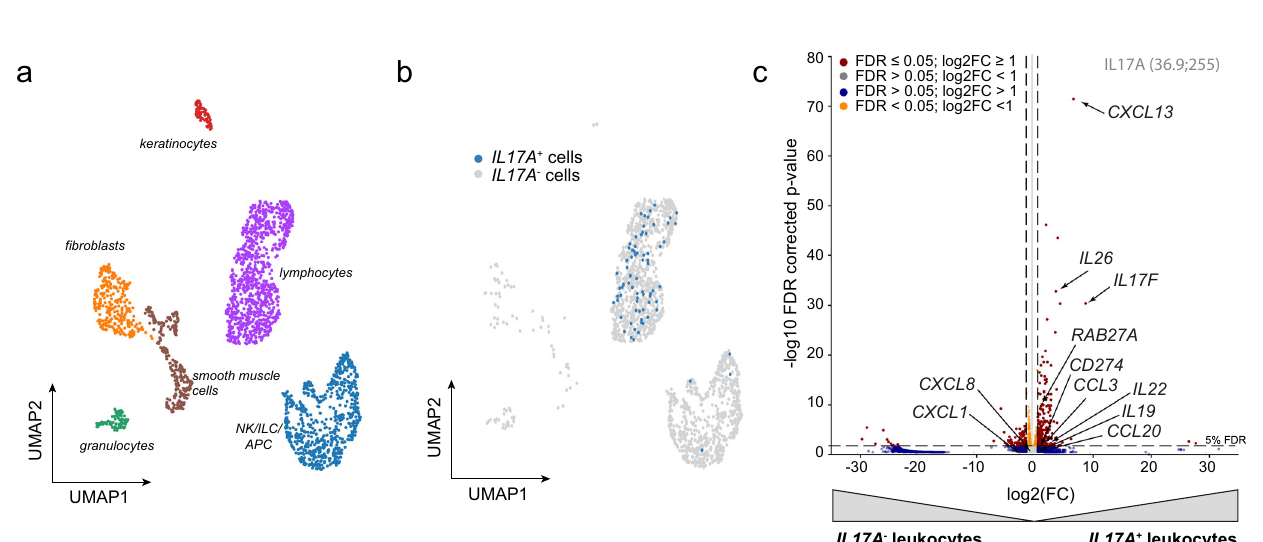
Fig. 3 | IL17A transcript-positive leukocyte spots are characterized by Th17 markers and IL17A tissue response genes. a UMAP (Uniform Manifold Approx- imation and Projection) plot showing the distribution of spots within the analyzed diseases AD, LP and Pso and non-lesional (NL) skin. b ST spots expressing IL17A transcripts and leukocyte marker genes and their location in epidermis or dermis. IL17A-positive spots are highlighted in blue. c Volcano plot analysing the gene expression pro fi le of IL17A transcript- positive leukocyte ( IL17A + ) versus IL17